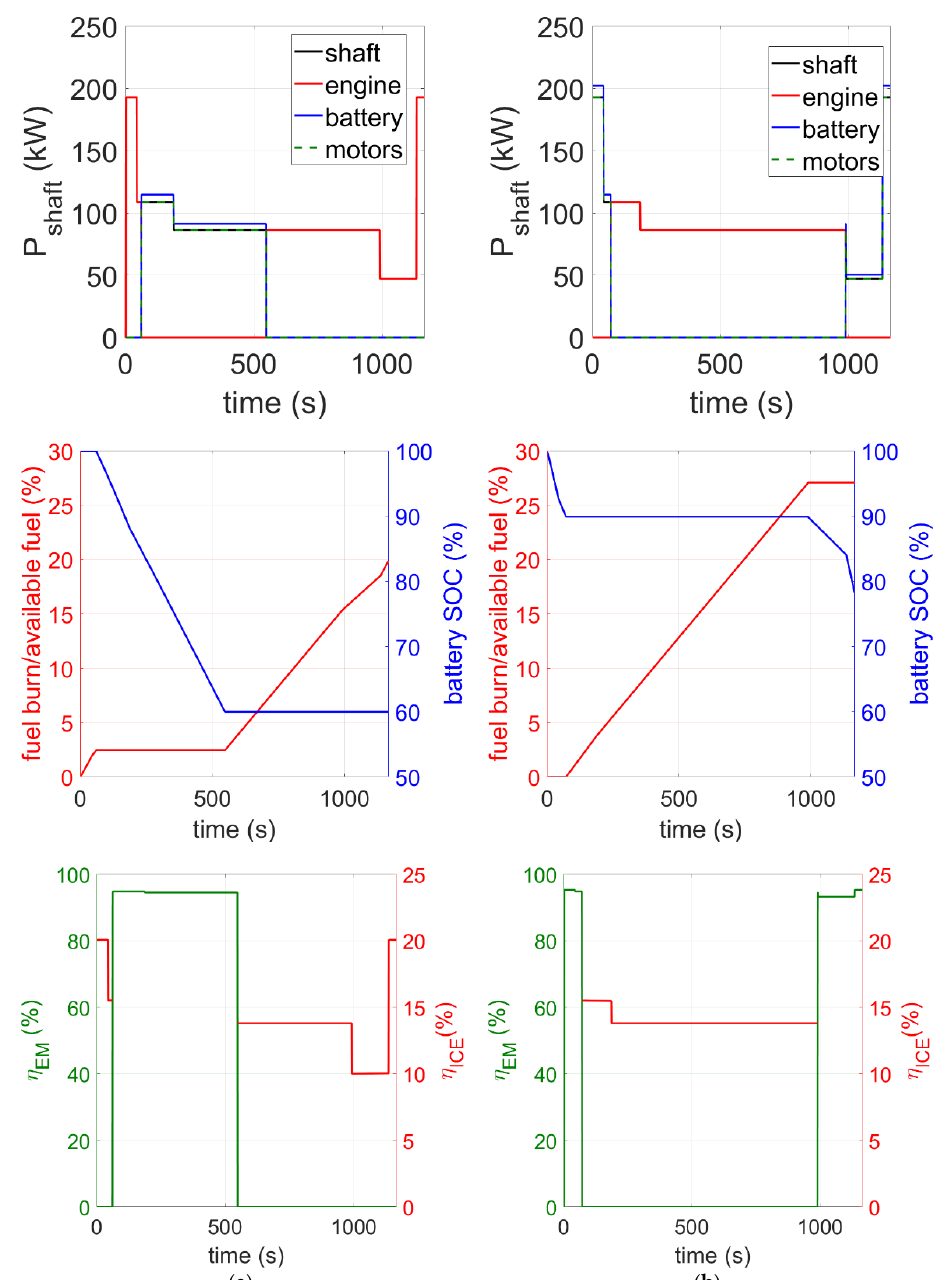
Figure 4. Power distribution, consumption, and efficiency time histories for the hybrid electric taxi with 2035 technology. ( a ) ECMS; ( b ) rule-based. with 2035 technology. ( a ) ECMS; ( b )